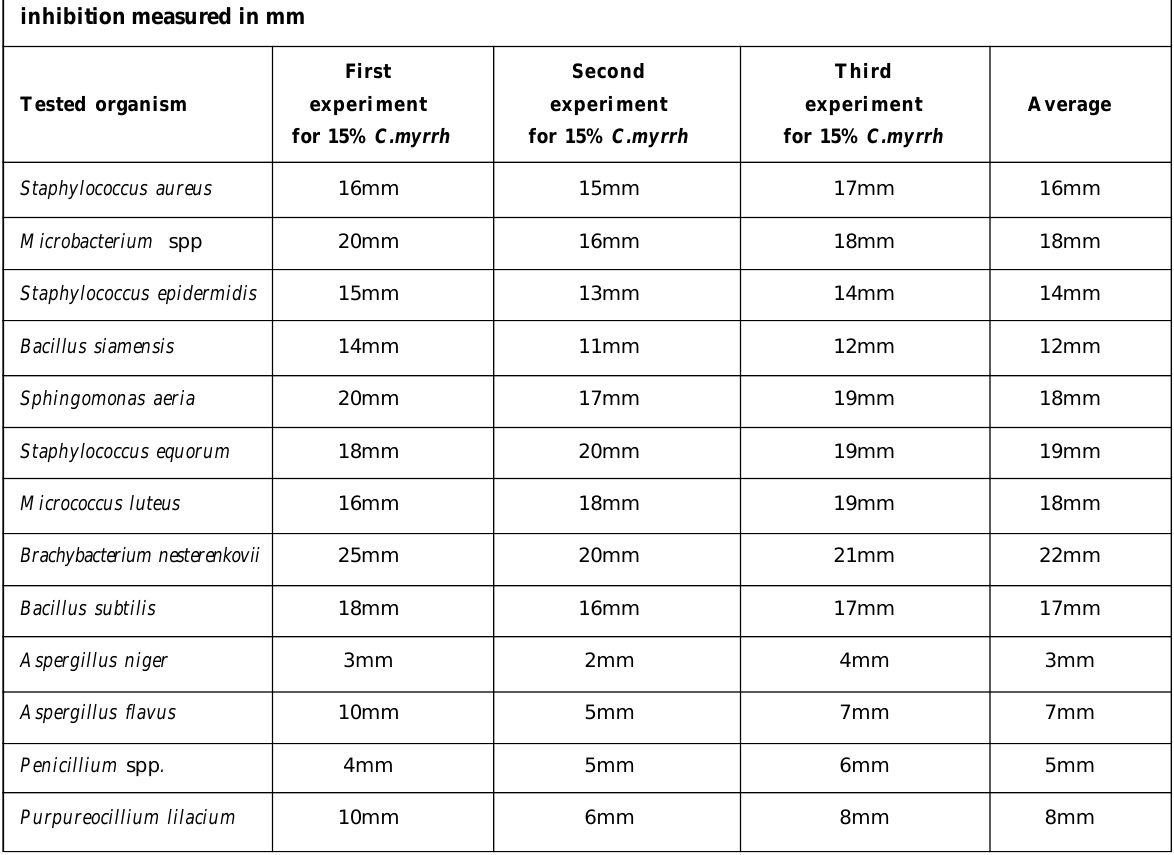
Figure 3 The effect of 15% of C. myrrh extract against microbial Table 7: The antimicrobial effect of 10% of Commiphora myrrh extract against microbial isolates. Zone of inhibition measured in